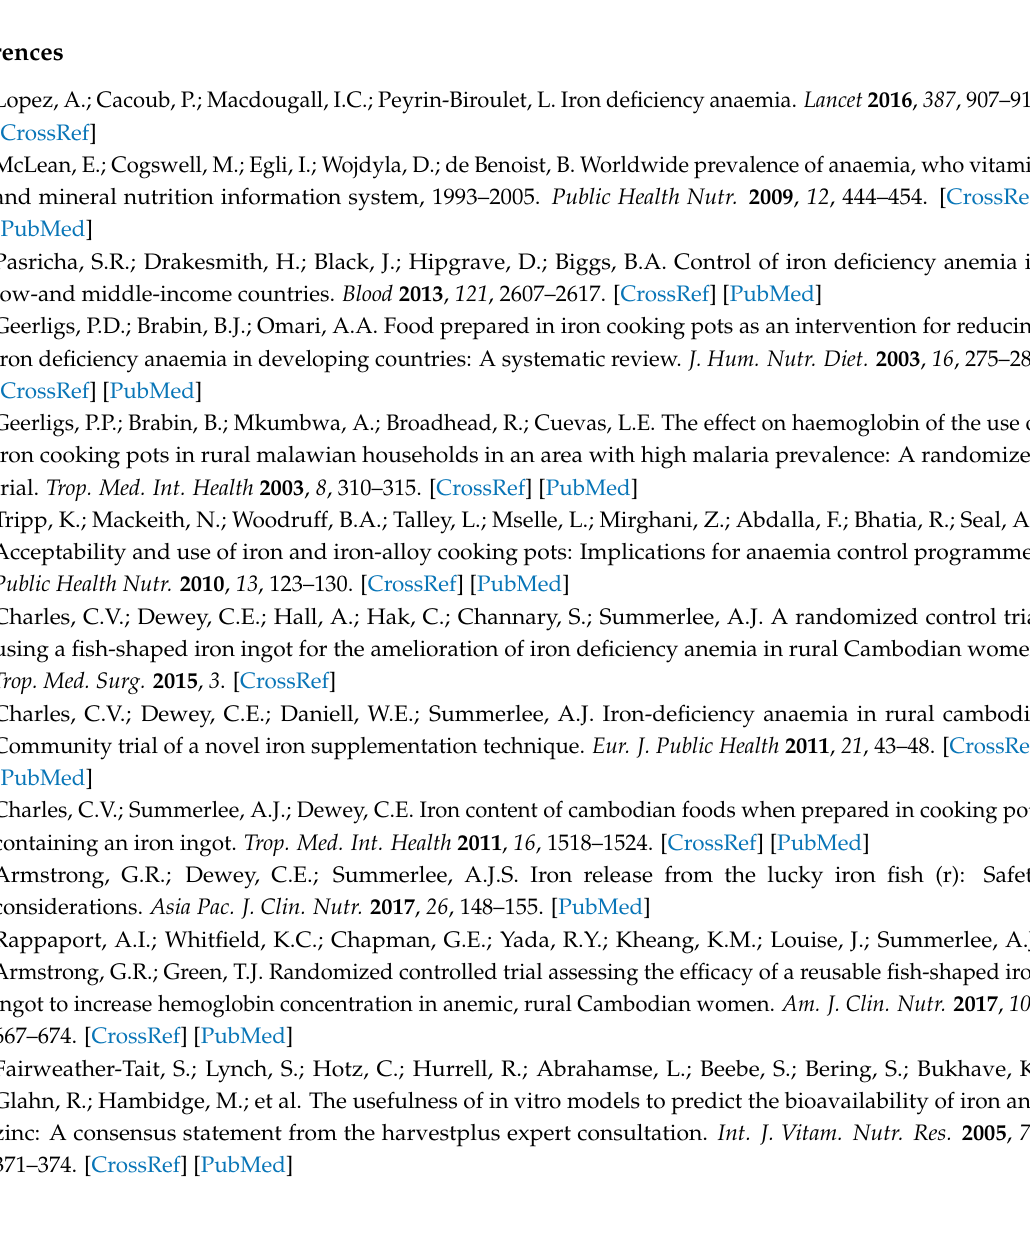
Figure S1: Iron content in cellular lysates of Caco-2 cells after treatment with the iron ingot (Lucky Iron Fish TM (LIF)) with or without ascorbic acid (AA), Figure S2: Iron content in cellular lysates of Caco-2 cells exposed to simulated gastrointestinal digestates of peas combined with the (Lucky Iron Fish TM (LIF))-iron, Table S1: Running conditions used for